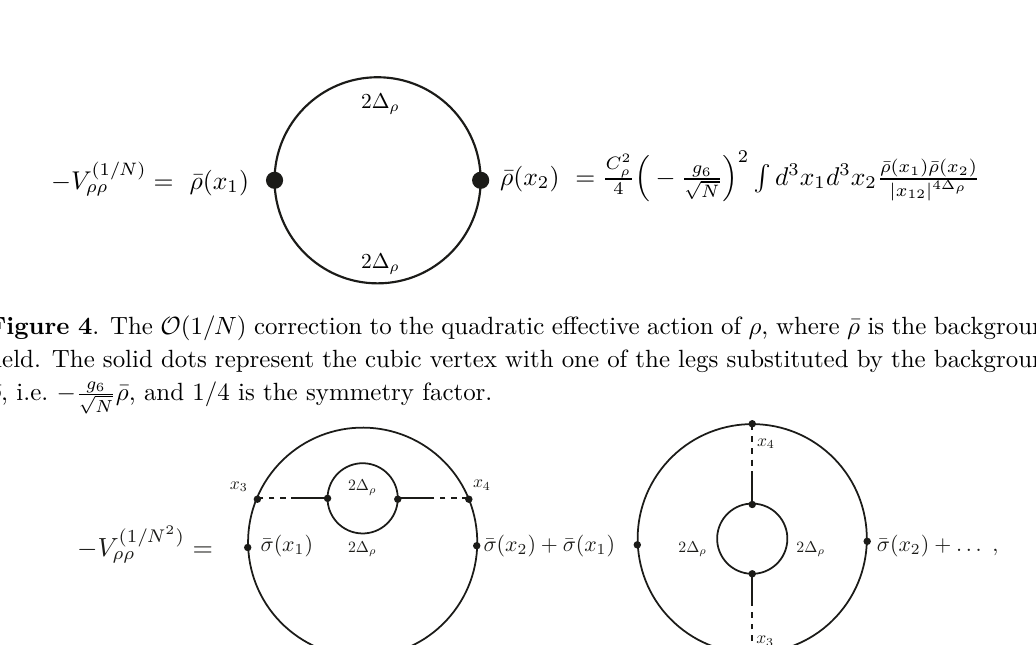
Figure 5 . The (1 /N 2 ) correction to the quadratic effective action of ρ . The background field O is ¯ σ ¯ ρ , given by (2.8). All propagators on the outer circles of these diagrams correspond to the ∼ field φ (the label 2∆ φ on the lines is suppressed). Ellipsis represent contribute to the anomalous dimension γ ρ